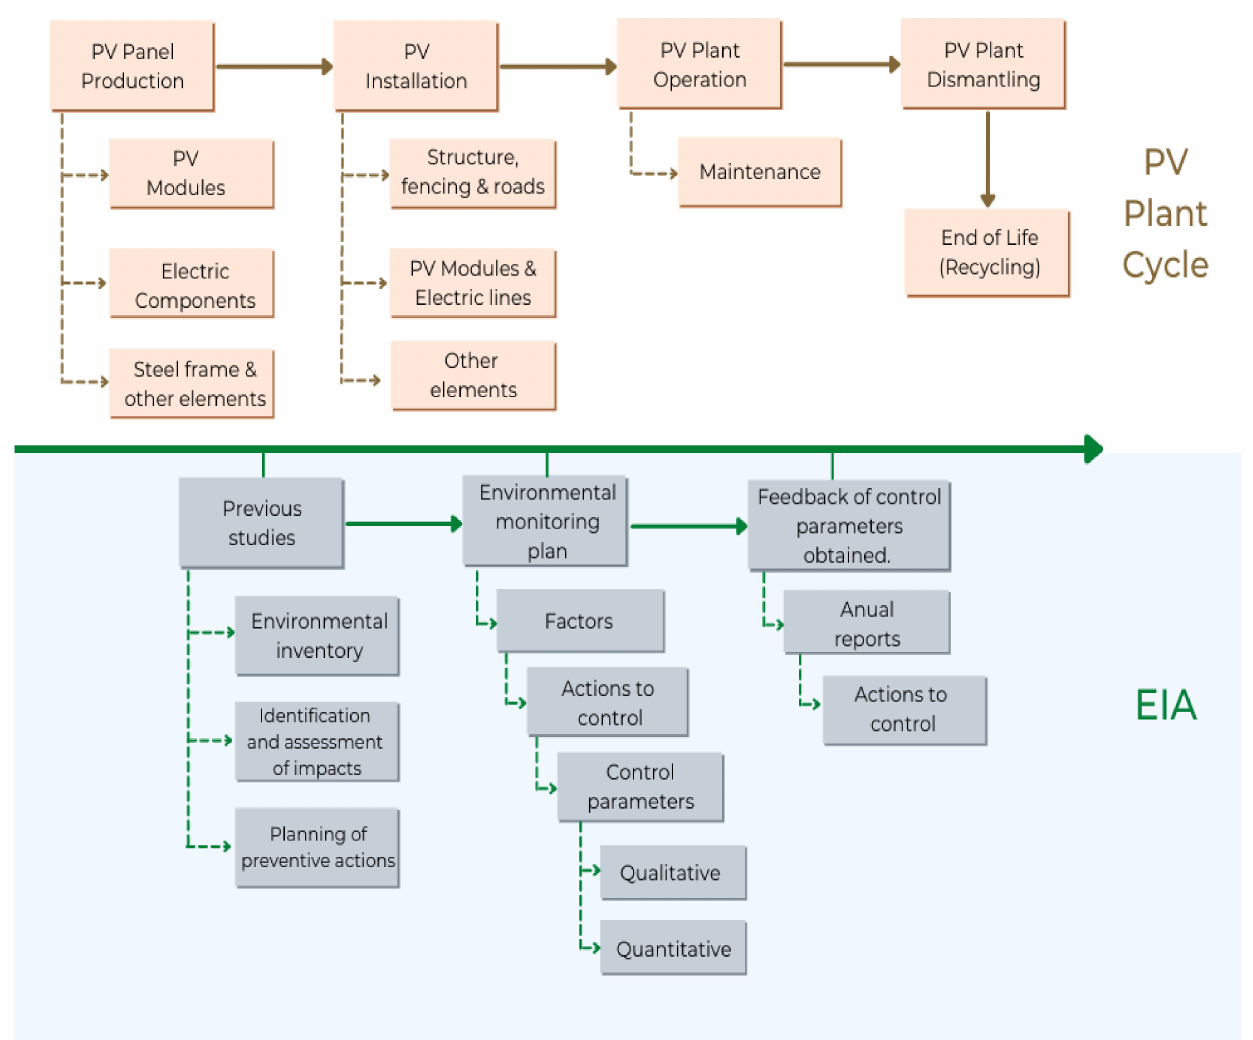
Figure 1. Schematic of the approach proposed for this paper. Own